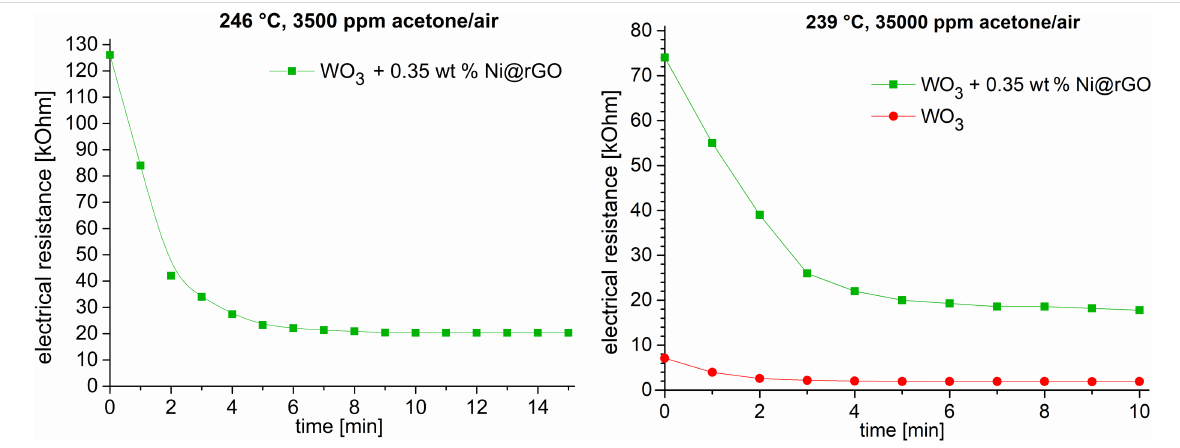
Figure 5: Left: time dependence of the sensor resistance values of the 0.35 wt % Ni@rGO/WO 3 samples (green) under exposure to a mixture of 3500 ppm acetone vapor in air. Right: time dependence of the sensor resistance values of the 0.35 wt % Ni@rGO/WO 3 (green) and WO 3 (red) sam- ples under exposure to a mixture of 35,000 ppm acetone vapor in air.